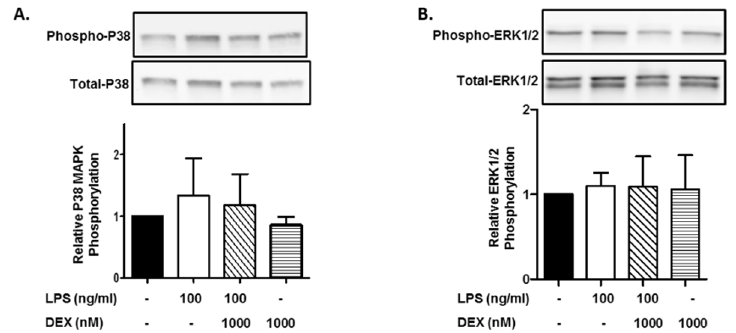
Figure 1. Effect of DEX on LPS-induced p38 MAPK and ERK1/2 activation. HMC3 cells were incubated with 1000 nM DEX for 30 min and further incubated with or without 100 ng/mL LPS for 15 min. Thereafter, the phosphorylation of p38 MAPK ( A ) and ERK1/2 ( B ) was analyzed by Western blotting. Phosphorylated p38 MAPK and ERK1/2 was normalized with total p38 MAPK and ERK1/2 and is expressed as a ratio to that of LPS-stimulated HMC3 cells without DEX. Representative images of Western blotting are shown above the graphs. Data are the means ± SD of 3 separate experiments.